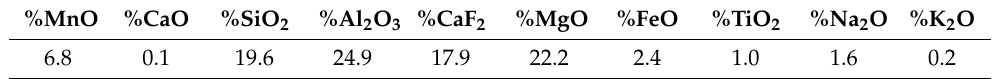
Table 2. Bulk chemistry of flux used in welding tests (mass%)